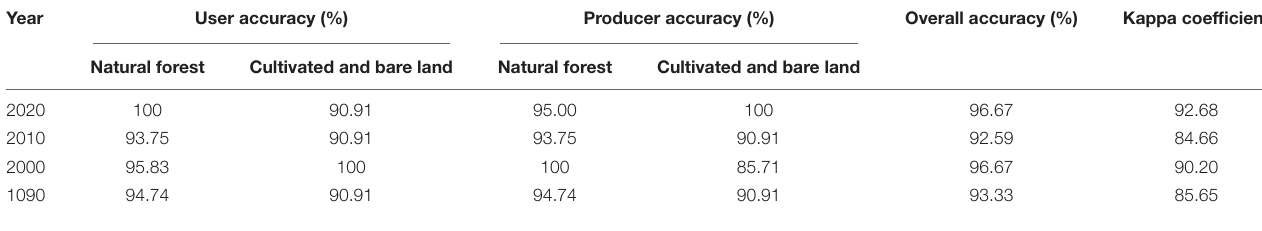
TABLE 1 | Accuracy assessments of land cover